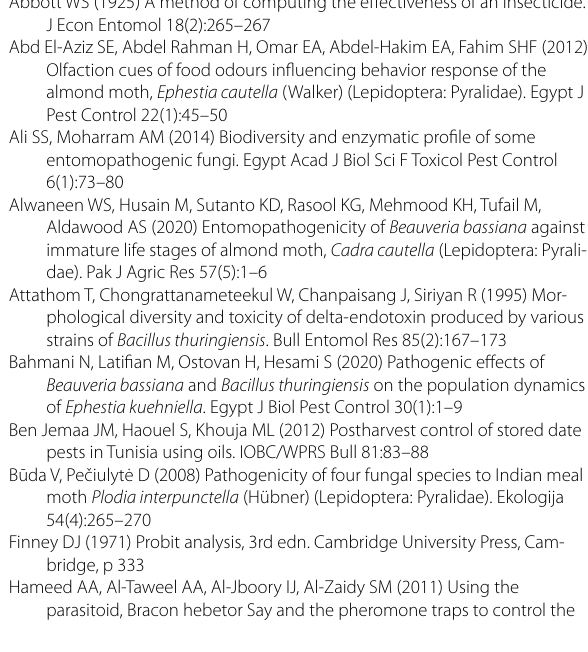
Mean in same column followed by the same letters is not significant L.S.D., least significant difference; Pr., probability level